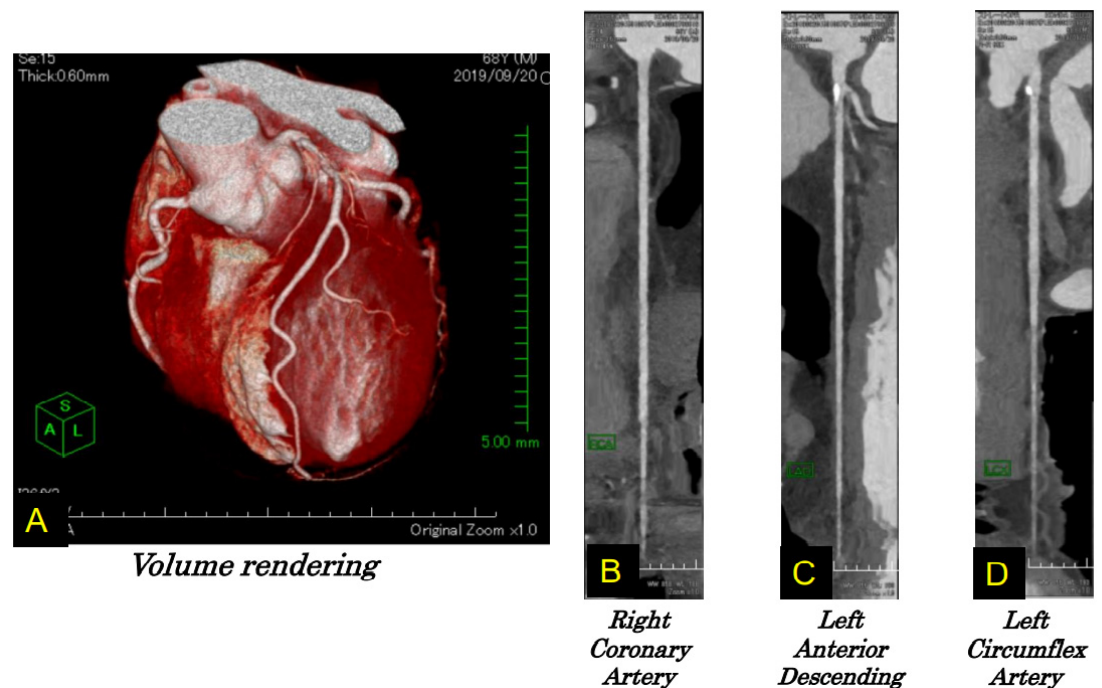
Figure 3. Coronary artery assessed by CT. In the volume rendering image ( A ), three vessels were observed. No stenosis can be seen in the right ( B ), left anterior descending ( C ), or left circumflex arteries ( D ). Reconstructed from [82].